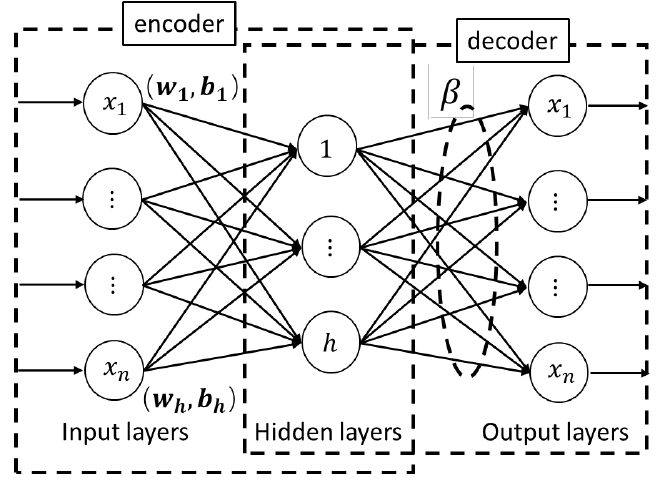
Figure 1. Extreme learning machine autoencoder (ELM-AE) network structure diagram.